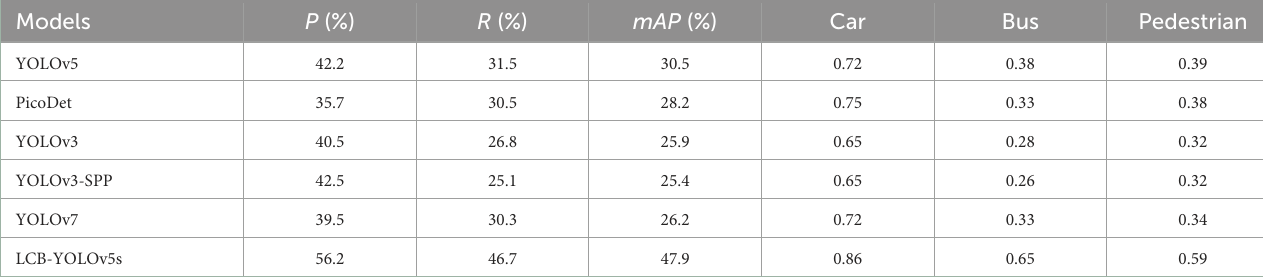
TABLE 3 Comparison of the proposed method and other approaches based on the Visdrone2019 dataset. Models